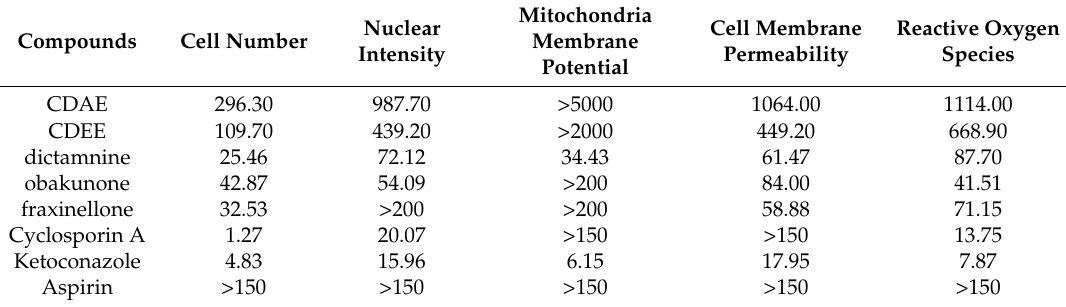
Figure 7. Estimation of drug-induced liver toxicity of dictamnine, obakunone, and fraxinellone using a high content imaging assay. ( A ) Cell number; ( B ) nuclear intensity; ( C ) mitochondria membrane potential (MMP); ( D ) cell membrane permeability; and ( E ) reactive oxygen species (ROS). Table 5. The IC 50 values of test compounds and the control compound in HepG2 cells using HCA.